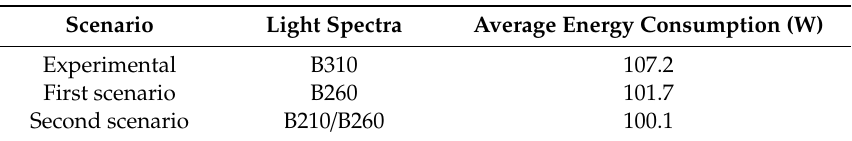
Table 6. Average energy consumption during 23 days of growth for the three simulated scenarios to reach the minimum plant